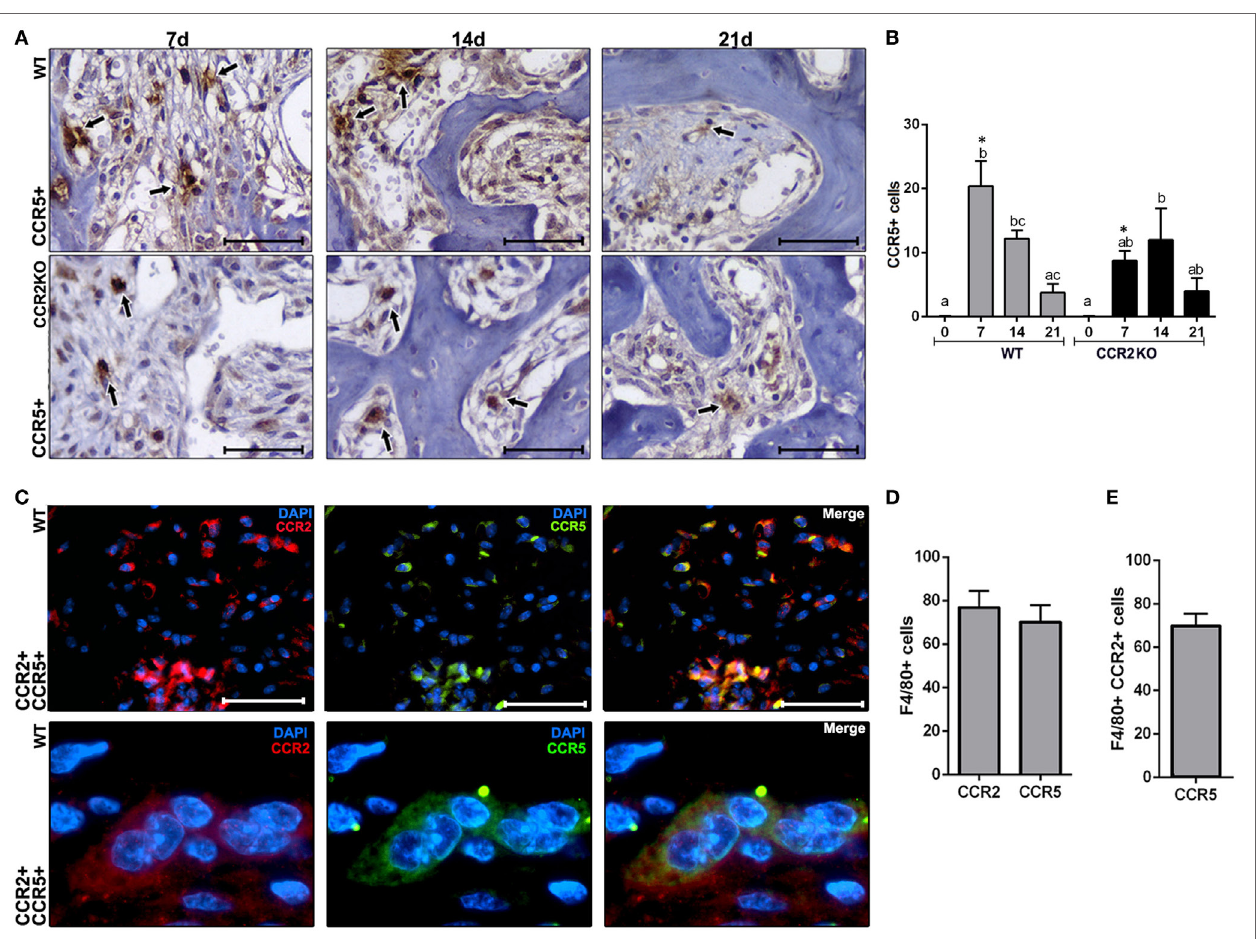
FigUre 7 | Immunological analysis of CCR2 and CCR5 along intramembranous bone healing in wild-type (WT) vs CCR2KO mice. (a) Representative sections from medial thirds of the socket at days 7, 14, and 21 post tooth extraction with immunolabeling for CCR5 + cells in WT and CCR2KO mice (as indicated with arrows) (40 × magnification; scale bar = 100 µm). (B) Quantitative analysis of CCR5 + cells in WT and CCR2KO mice at days 0, 7, 14, and 21 post-extraction. Different letters indicate significant differences in each time point ( p < 0.05); symbol * indicate significant differences between WT vs CCR2KO at the same time point. (c) Immunocolocalization of CCR2 (TRITC) and CCR5 (fluorescein isothiocyanate) in inflammatory cells at day 7 post tooth extraction in WT mice (100 × magnification). (D,e) The phenotype of F4/80 + cells from alveolar socket at day 7 post tooth extraction in WT mice, evaluated by flow cytometry, and depicted as the number. Results are presented as mean and